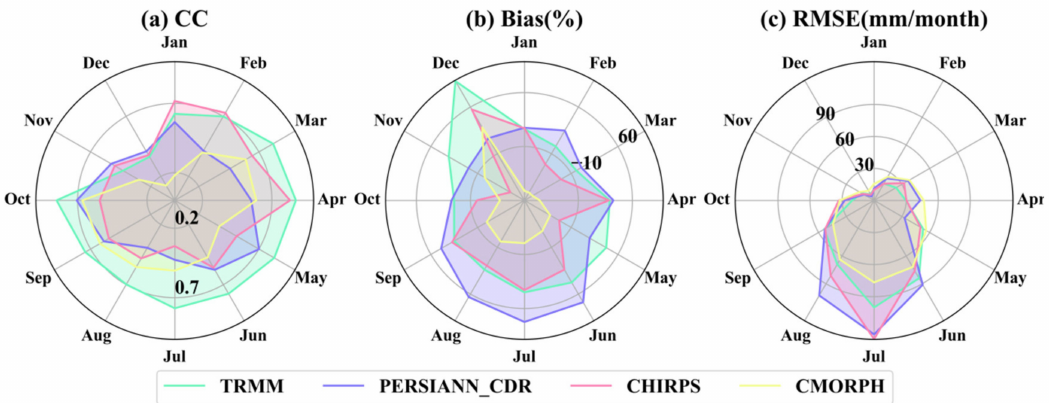
Figure 7. Evaluation metrics calculated by each month’s precipitation for rain gauges and four corresponding product grids: ( a – c ) CC, Bias, and RMSE, respectively.